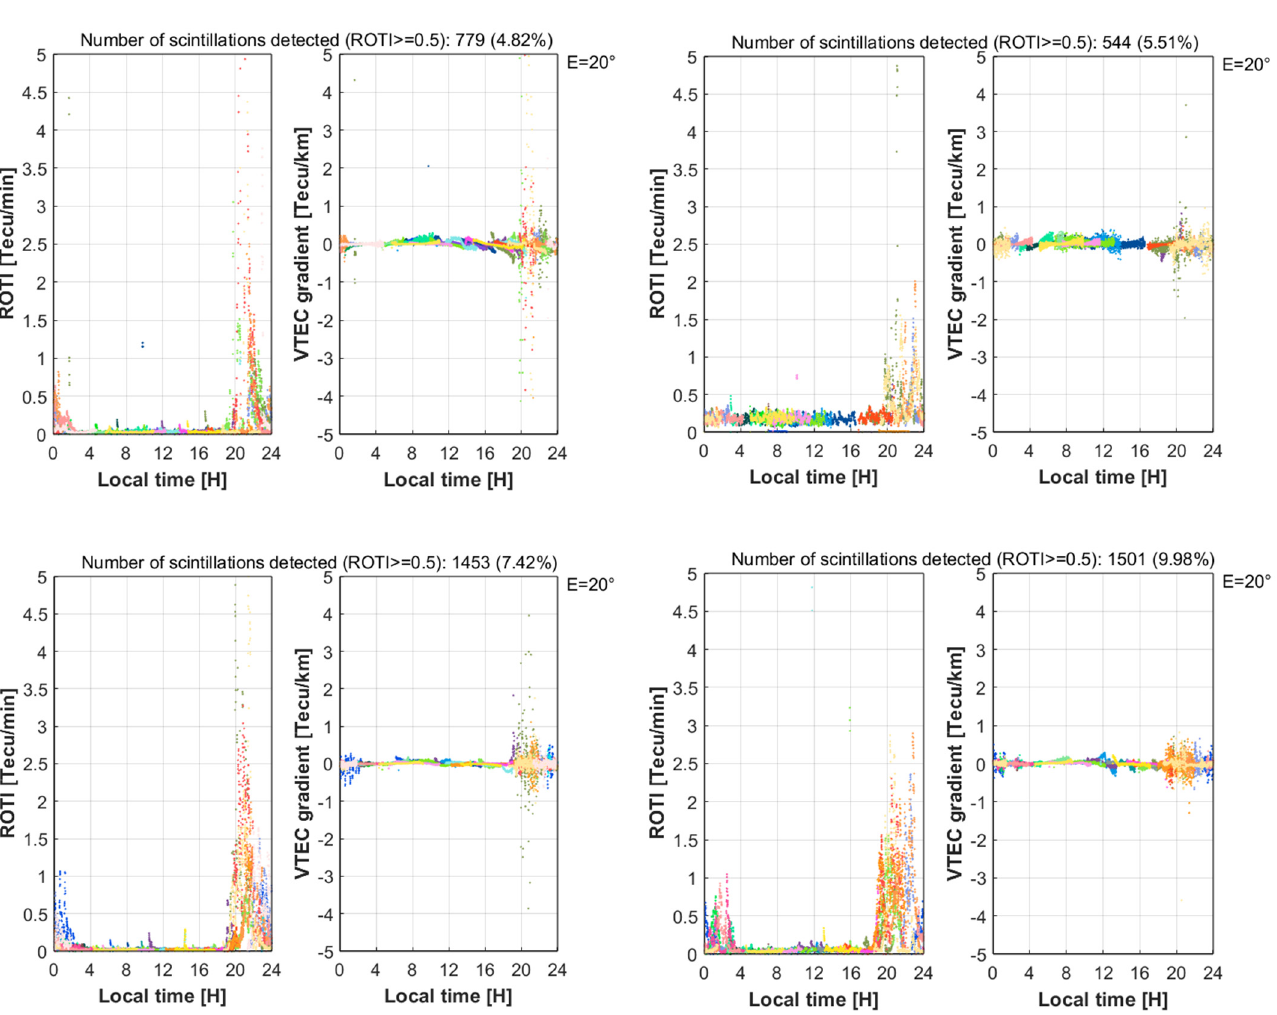
Figure 9. Ionospheric irregularities including ROTI and VTEC gradient values at BAKO station on 19 October ( top-left ), HCM station on 20 October ( top-right ), CUSV station on 26 October ( bottom-left ), and at HUE station on 31 October ( bottom-right ). While the ROTI shows the temporal distribution of ionospheric disturbances, the VTEC gradient indicates both spatial and temporal distributions of plasma ionospheric irregularities.